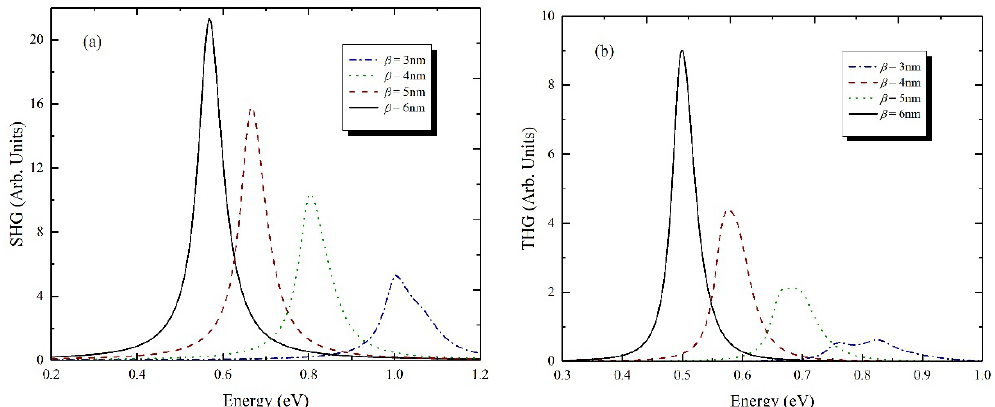
Figure 7. Dependence of the second harmonic generation ( a ) and third harmonic generation ( b ) on the energy of the incident light for four different values of β .